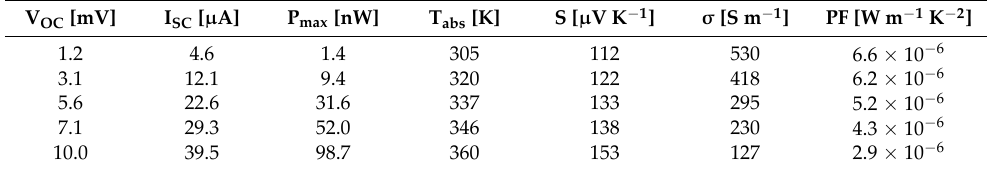
Table 1. The summarized measured and calculated values of open‑circuit voltage, short‑circuit cur‑ rent, maximal power output, Seebeck coefficient, electric conductivity and power factor for different temperatures (see Figure